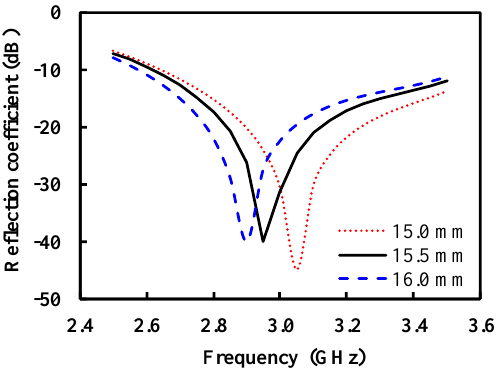
Figure 11. Simulated reflection coe ffi cient for the human body with ε r = 20 as a function of the thickness ( t d ) of the IMDL with ε r = 4.5 .